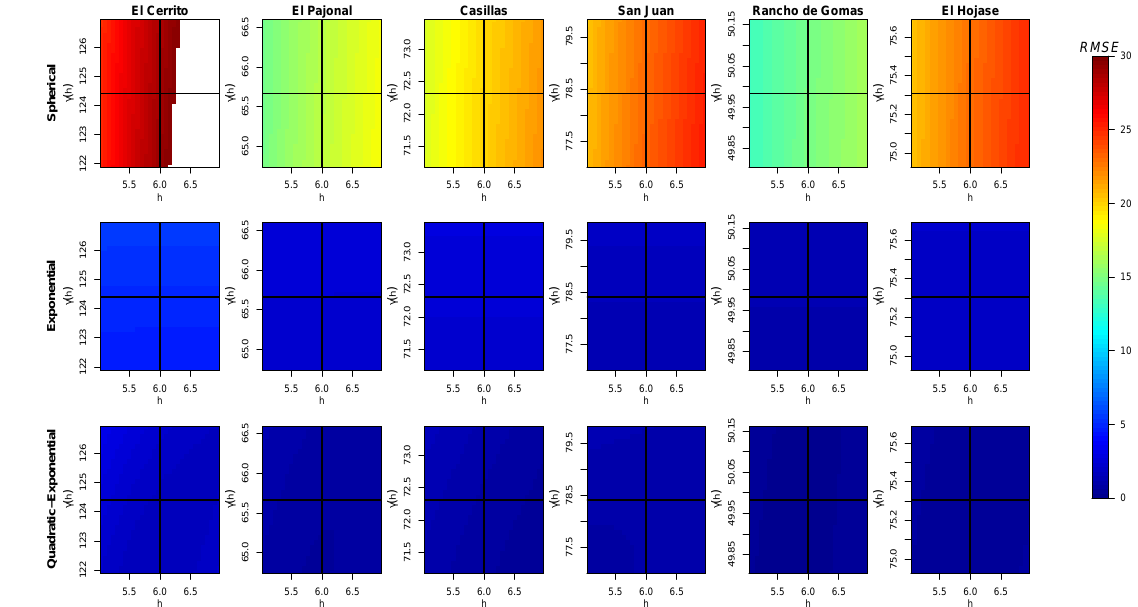
Figure A3. Obtained values of RMSE (color bar) for different pair of data ( r , γ ( r )) when fitting a curve for the variogram of each station with the three models and without considering the nugget effect. The intersection of the black solid lines tags the real position ( r , γ ( r )) . The white areas correspond to higher values than those shown on the color